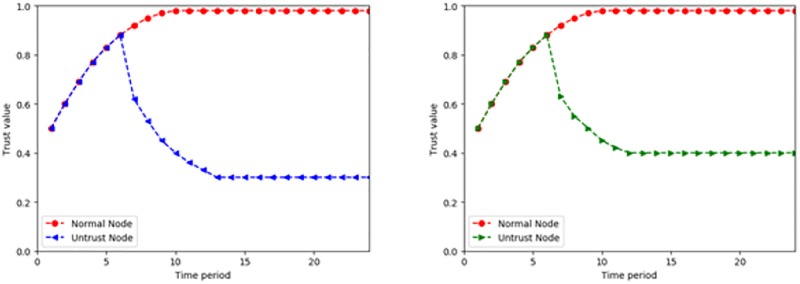
Change trend of node trust value.(a) Untrust node abandons packerts randomly. (b) Untrust node sends packets repeatedly.